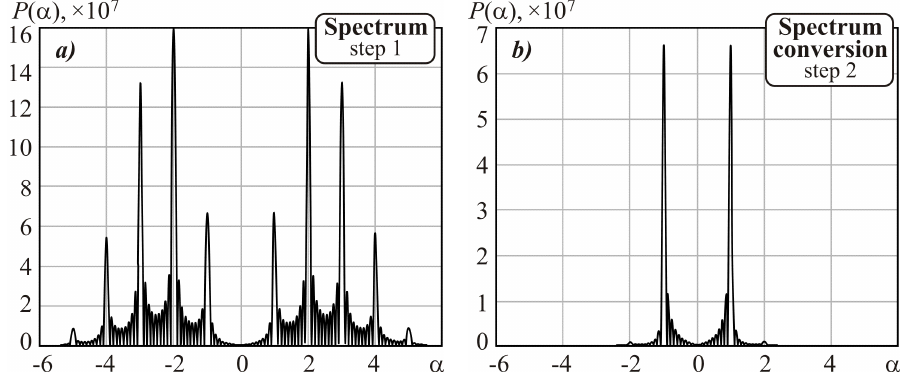
Figure 3. The spatial spectrum of the field of Equation (1): ( a ) initial and ( b ) truncated following function of Equation (5).